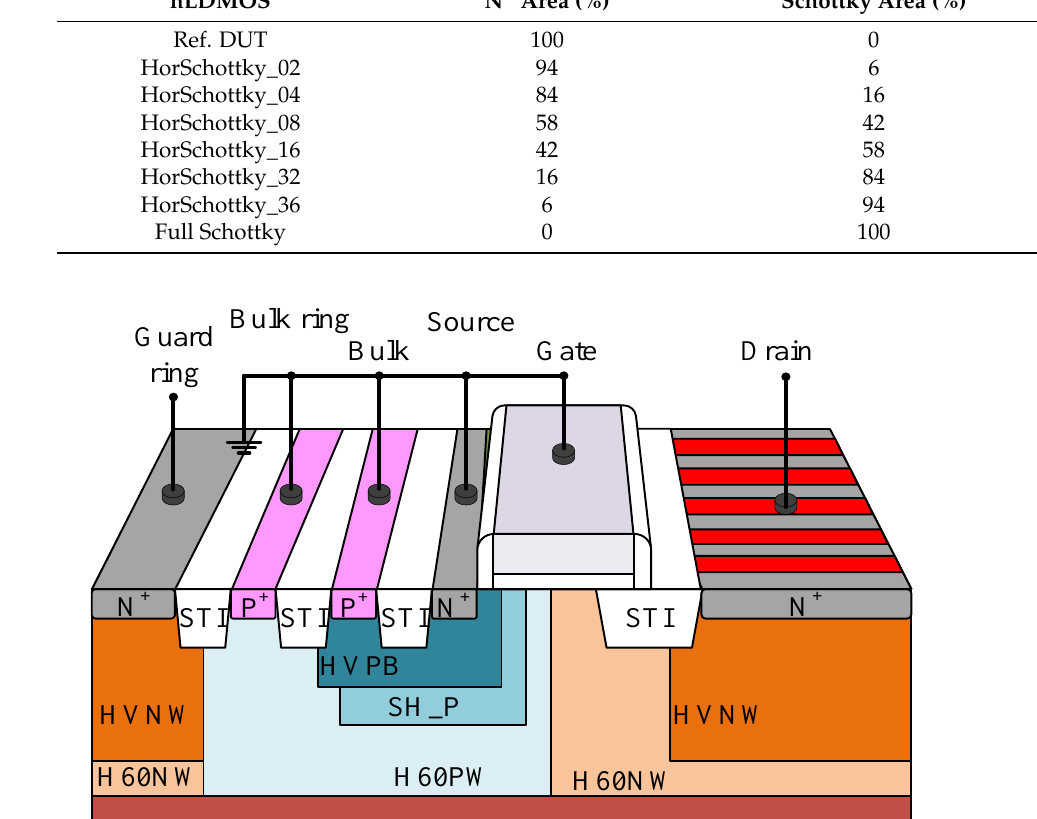
Table 1. Area ratios of N + and Schottky diode regions in the drain side. nLDMOS N + Area (%)